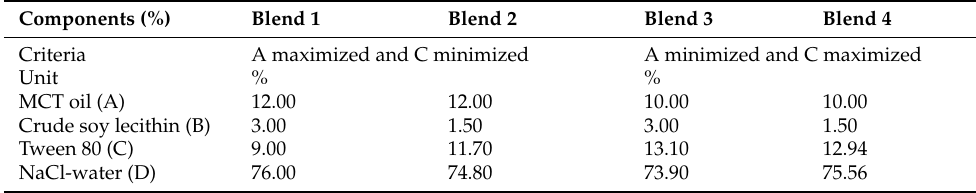
Table 2. Optimization criteria and generated